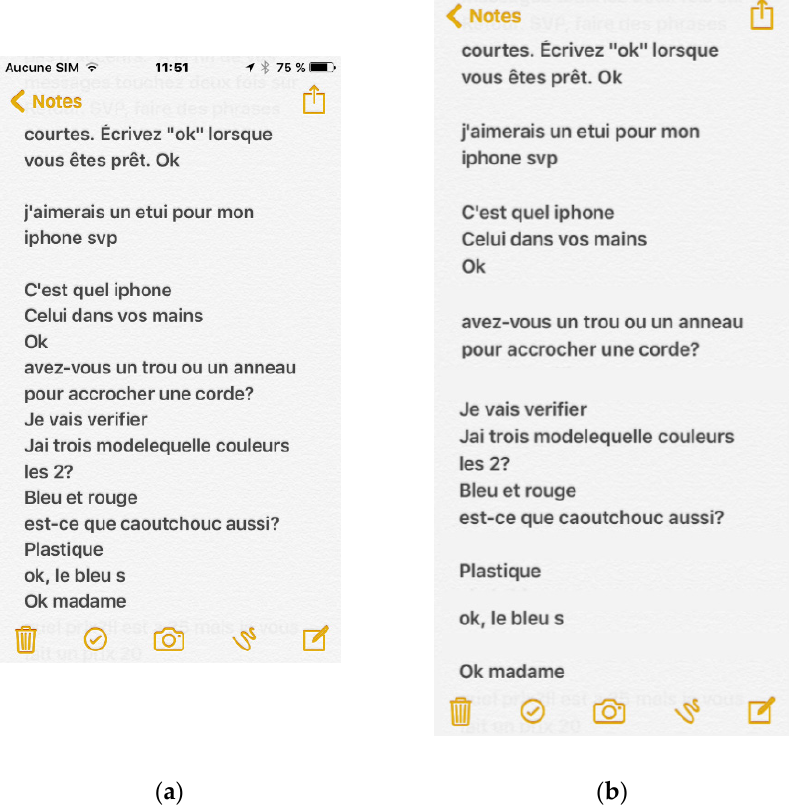
Figure 4. ( a ) Screenshot of the discussion text messages from Test 1 on iOS Notes. ( b ) Test 1 discussion text messages organized by setting up returns at the end of messages .